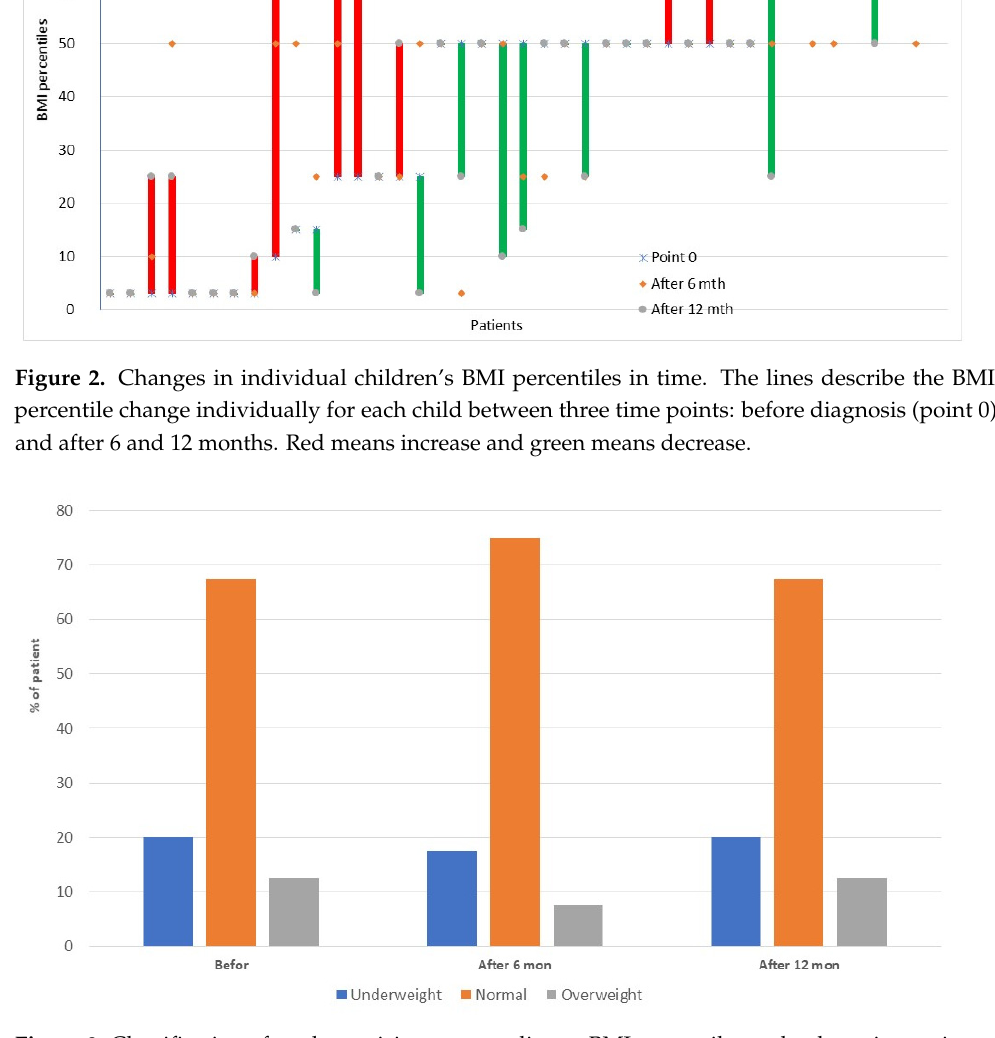
Figure 3. Classification of study participants according to BMI percentiles at the three time points. Table 2. Changes of biochemical parameters in the studied group.